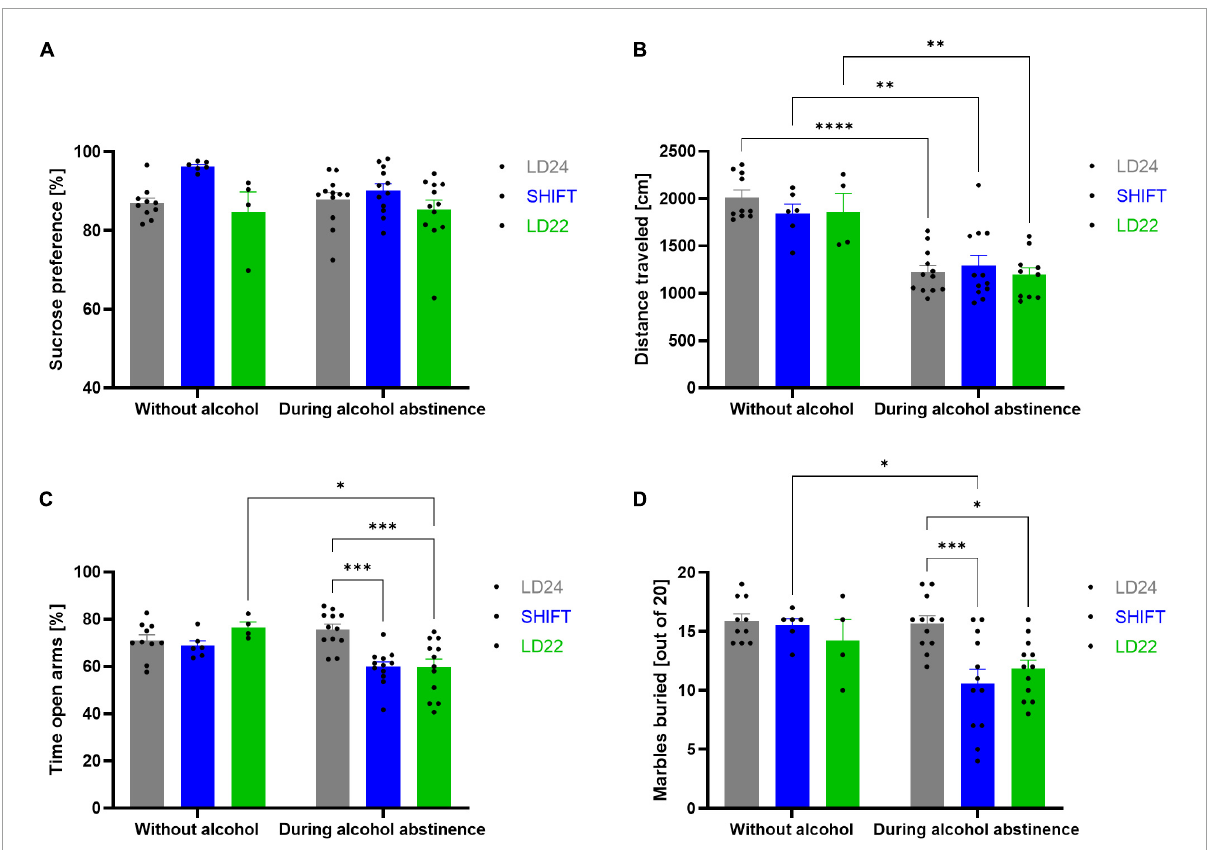
FIGURE5 Effect of light-dark (LD) schedule and alcohol abstinence on behavioral performance. (A) Sucrose preference (%) over a 3-h test period, (B) distance traveled in the OFT, (C) the percentage of time spent in the open arms during the EPM, and (D) marbles buried within the MBT. One-way ANOVA, Tukey’s multiple comparisons test: ∗∗∗∗ p < 0.0001, ∗∗∗ p < 0.001, ∗∗ p < 0.01, ∗ p < 0.05; ± SEM; n = 4–12/LD condition.